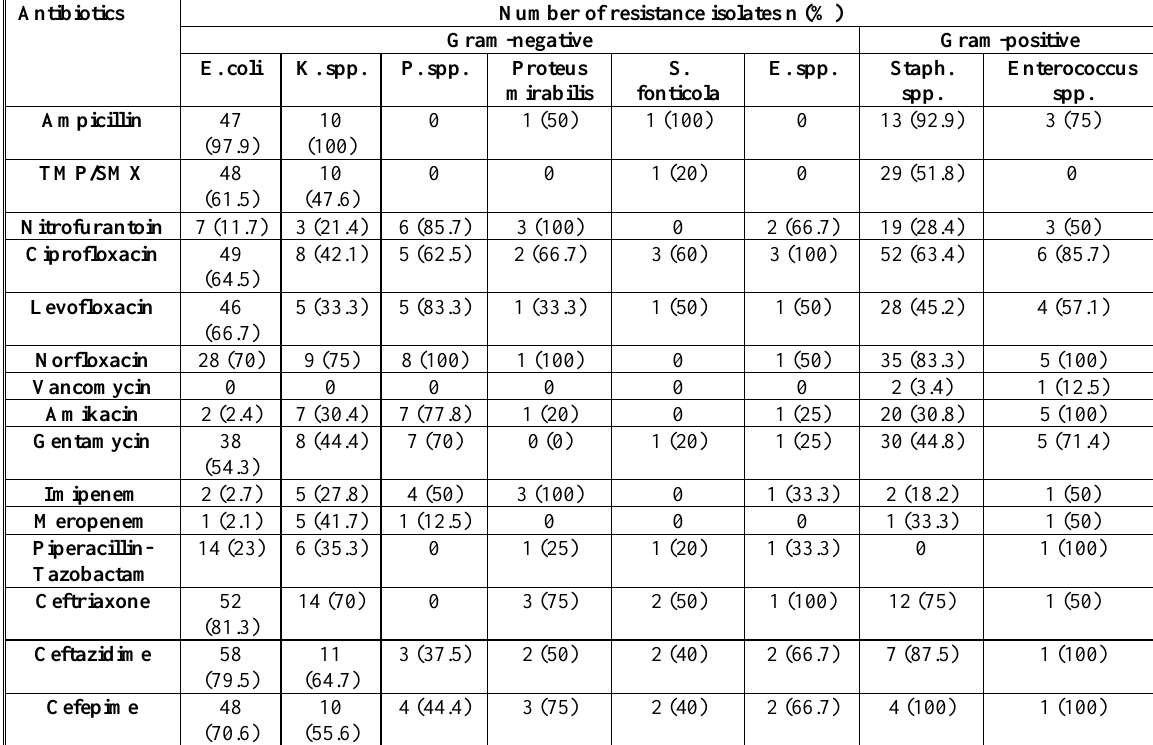
Table 3. Antibiotic resistance profile of common